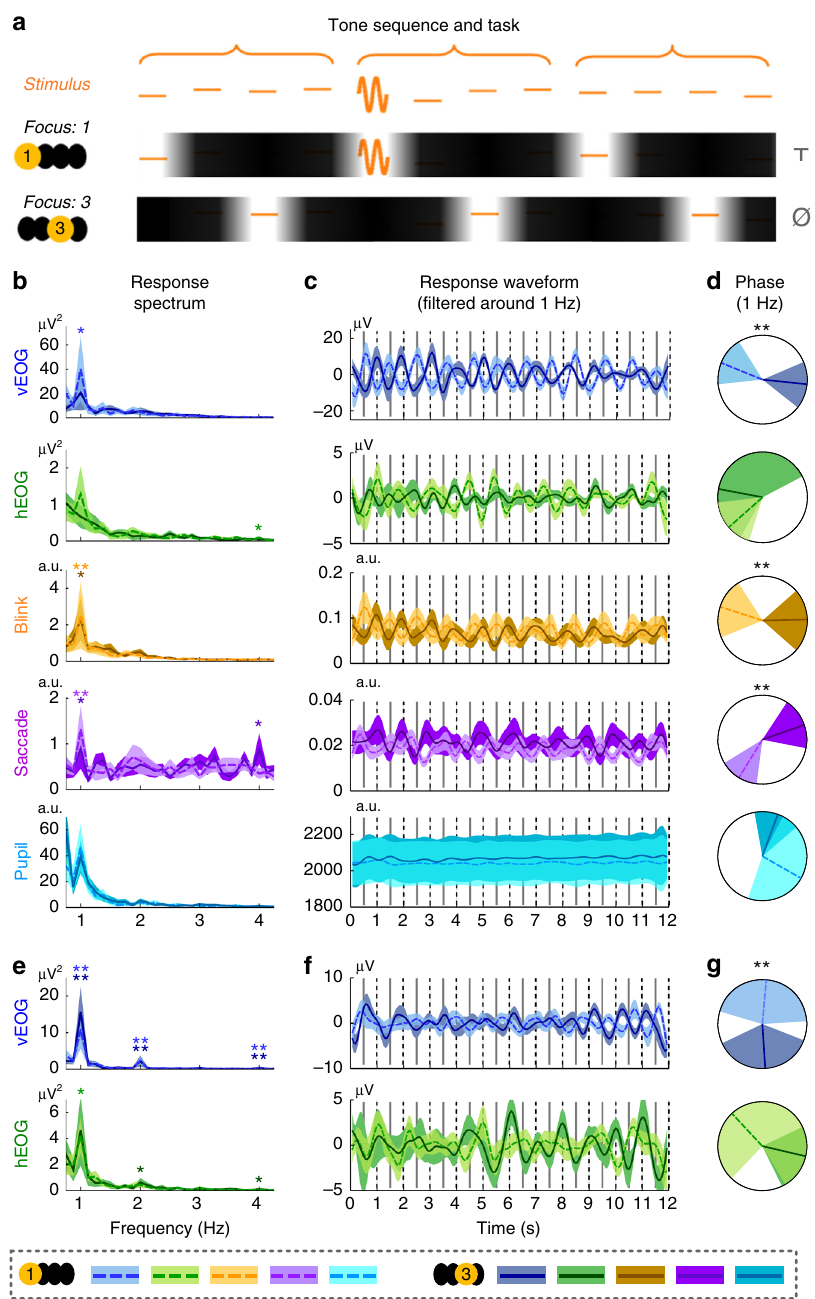
Fig. 4 Ocular activity tracks high-level perceptual structures in a tone sequence and its phase is modulated by temporal attention. a Stimulus and task. The stimulus is an isochronous sequence of tones and the listeners are asked to group every four tones into a perceptual group. The task is to attend to the 1st syllable of every perceptual group in one condition and attend to the 3rd syllable in the other condition. Unattended syllables are shaded in the illustration. The listeners detect whether the attended tones are replaced by frequency modulated tones. In the illustration, T means that a target appears while Ø means that no target appears. Panels b – d show the results from the eyes open condition while panels e – g show the results from the eyes closed condition. In all these panels, dashed lines and lighter color indicate conditions attending to the 1st tone while solid lines and darker color indicate conditions attending to the 3rd tone. b and e Response spectrum. The shaded area in panels b , c , e , and f covers 1 SEM across participants ( N = 16) on each side. The onset of the 1st tone of each perceptual group is marked by a dashed vertical line while the 3rd tone is marked by a solid line. The P -value, mean, and SEM of each spectral peak are shown in Supplementary Table 4. c and f Response waveform fi ltered around 1 Hz, which is strongly modulated by attention. d and g The response phase extracted based on the Fourier analysis. The shaded area covers the 95% con fi dence interval of the mean phase. If the phase difference between conditions is signi fi cant, stars are marked on top of the unit circle.* P < 0.05; ** P <